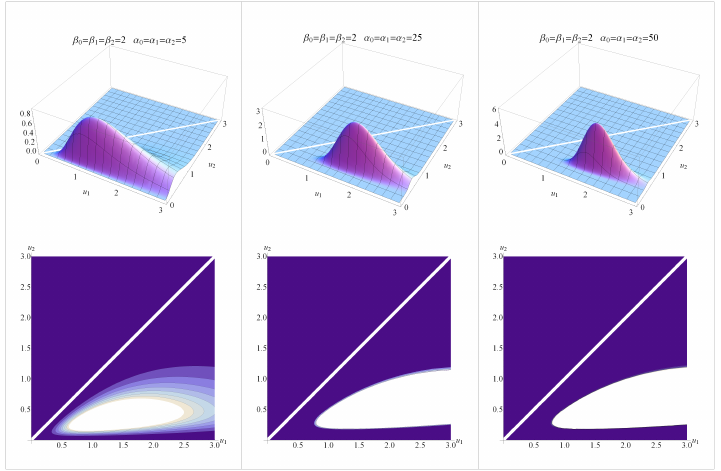
Figure 4. Equal sample sizes, no shift in the variance.